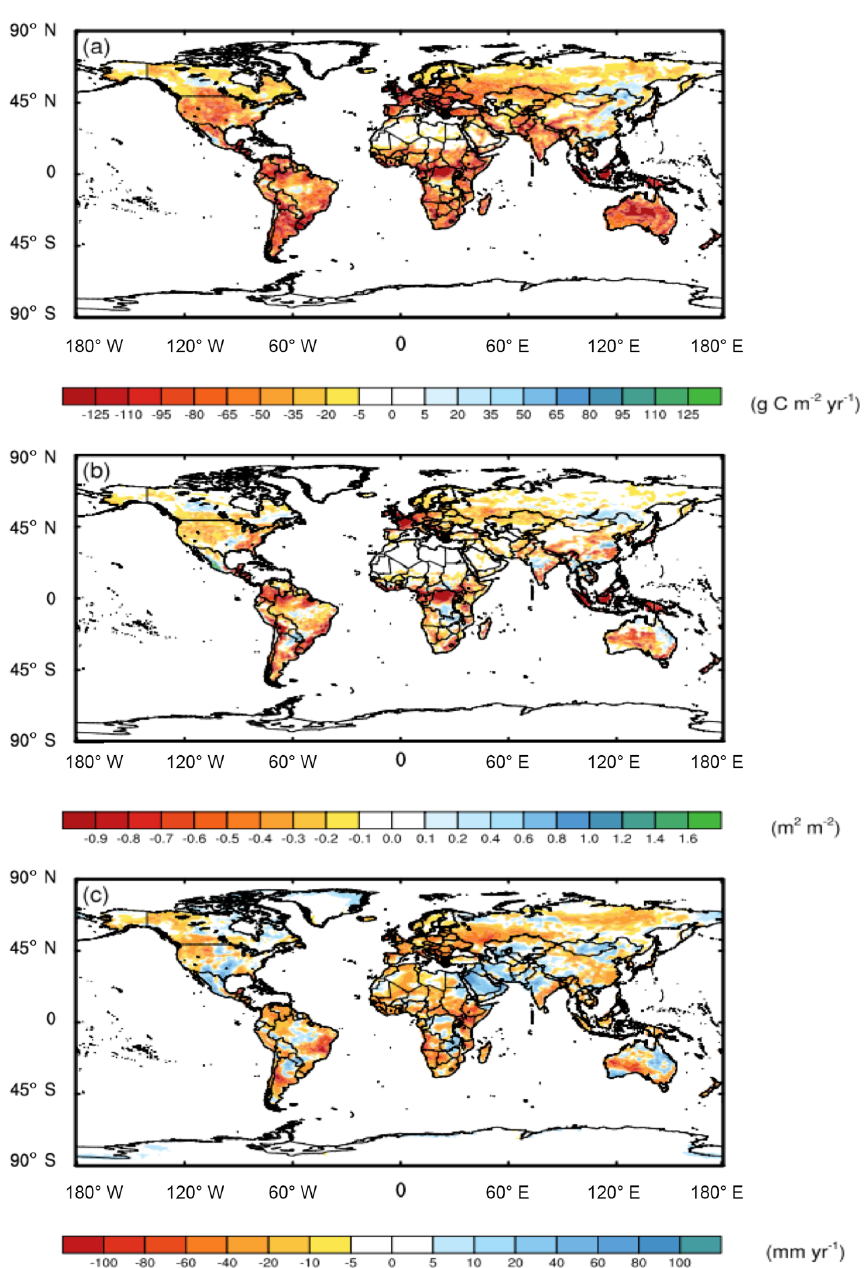
Figure 1. The C expended on symbiont-mediated N acquisition altered the spatial patterns of (a) NPP, (b) LAI, and (c) ET. These results were obtained from CAM runs with and without the symbiont sub-module (CLM-FUN) and represent the mean of the last 10 years of the simulation from 1995 to